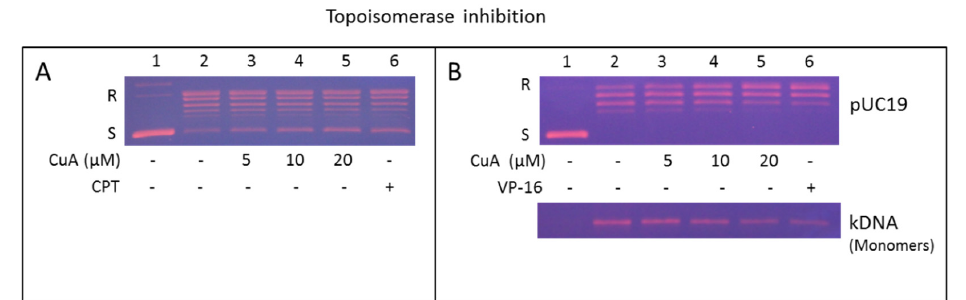
Figure 5. Cuminaldehyde inhibited topoisomerase I as well as II activities in human colorectal COLO 205 cells. ( A ) Cuminaldehyde inhibited topoisomerase I activity. Nuclear proteins of COLO 205 cells interacted with the indicated cuminaldehyde concentrations in a topoisomerase I’s specific reaction mixture (lanes 3–5), or 60 μ M of camptothecin (CPT, a specific topoisomerase I inhibitor and used as positive control, lane 6), or the vehicle (1% dimethyl sulfoxide, lane 2). Lane 1, pUC19 DNA only; ( B ) Cuminaldehyde inhibited topoisomerase II activity. DNA relaxation test (upper panel) and decatenation test (lower panel). Nuclear proteins of COLO 205 cells were added to a specific topoisomerase II reaction mixture with the specified cuminaldehyde concentrations (lanes 3–5) or 60 μ M of camptothecin (a specific suppressor of topoisomerase II and used as positive control, lane 6), or the vehicle (one percent dimethyl sulfoxide, lane 2). Lane 1, Interwined pUC19 DNA (upper panel) or kinetoplast DNA (lower panel) only. kinetoplast DNA is an extensive chain of plasmids. When kinetoplast DNA is examined using electrophoretic analysis, it gets the gel only a lightly (figure not demonstrated). Consequent to topoisomerase II’s decatenation, small monomeric circles of nucleic acid were produced (lower panel, lane 2–6). This is the representative of six experiments. CPT, camptothecin; CuA, cuminaldehyde; kDNA, kinetoplast; S & R, Interwined and the unrestrained forms of the pUC 19 plasmid, respectively; VP-16,